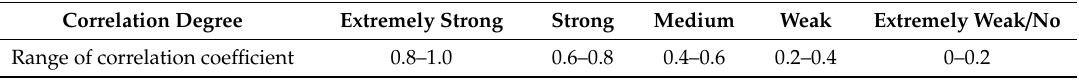
Table 1. Degree of correlation and the corresponding range of correlation coe ffi